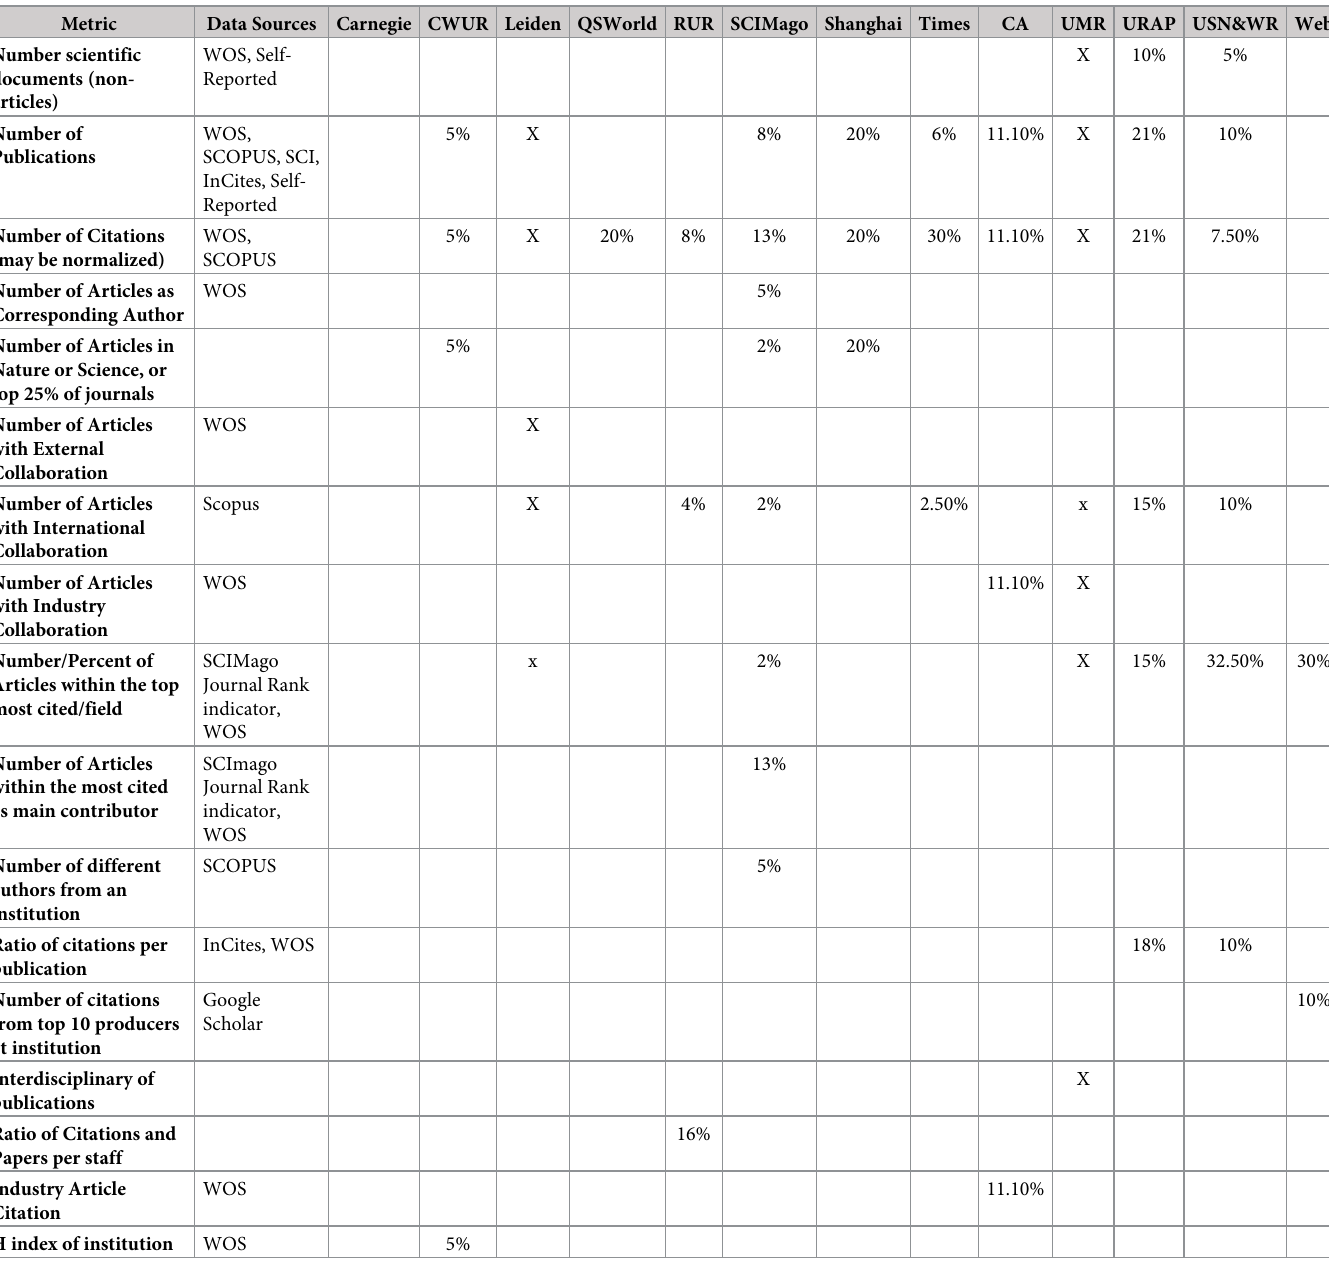
Table 3. Research indicators by publication and citation metrics (percent of contribution to total score, not all percentages may sum to 100, due to rounding.).